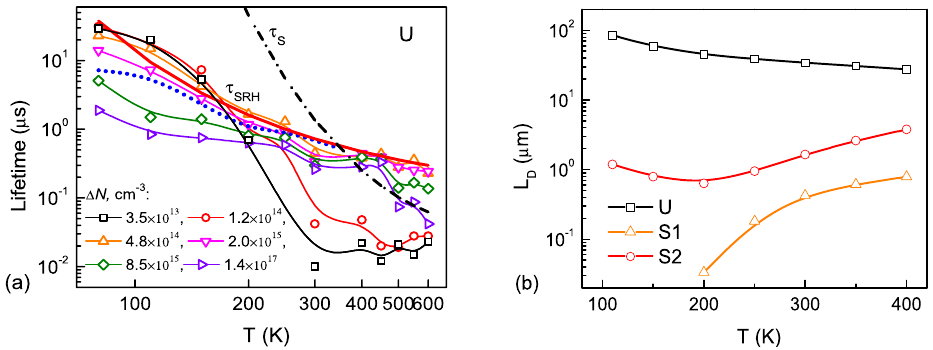
Figure 4. Charge carrier dynamics analysis for crystal U. ( a ) Symbols: temperature and injection dependent TA lifetimes. For comparison, the dotted blue line shows lifetimes from PL decay. The thick solid curve corresponds to SRH lifetime approximation. Surface lifetime at highest excitation is shown by the dash-dot line. ( b ) Temperature-dependent charge carrier diffusion length estimate from SRH lifetimes in ( a ) and mobility in Fig.